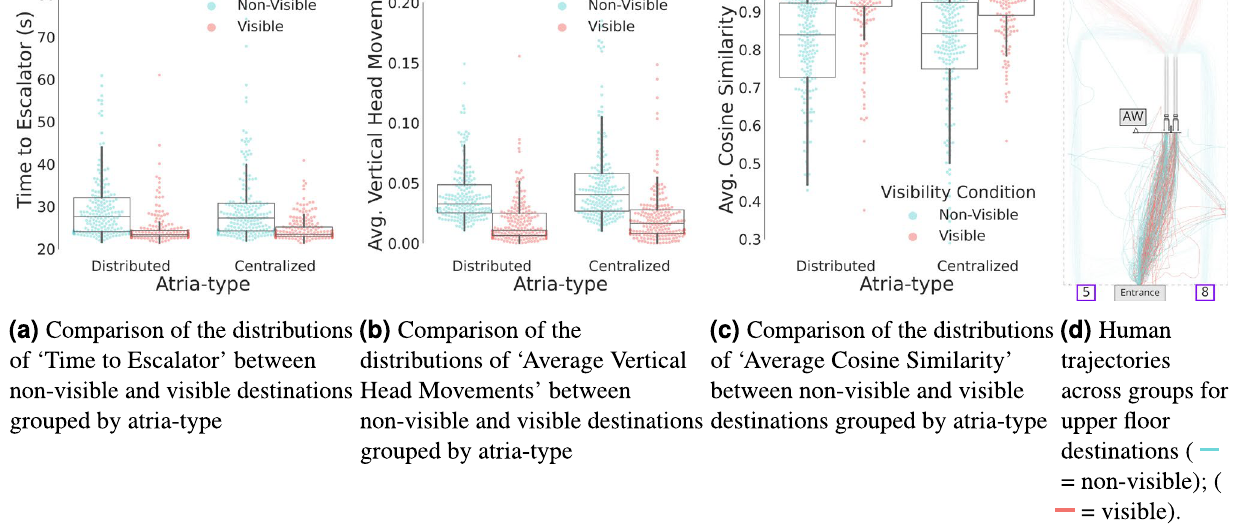
Figure 3. Figures ( a – c ) show the relationship between ‘ visible ’ or ‘ non-visible ’ trials (within each group, i.e., distributed versus centralized atria-type buildings) and each of the wayfinding behavioral measures. Figure ( d ) shows participants ’ trajectories within the analysis window (across both groups), colored by visibility conditions. Software used to create these figures: Python 34 (version 3.5.8), https:// www. python. org/ downl